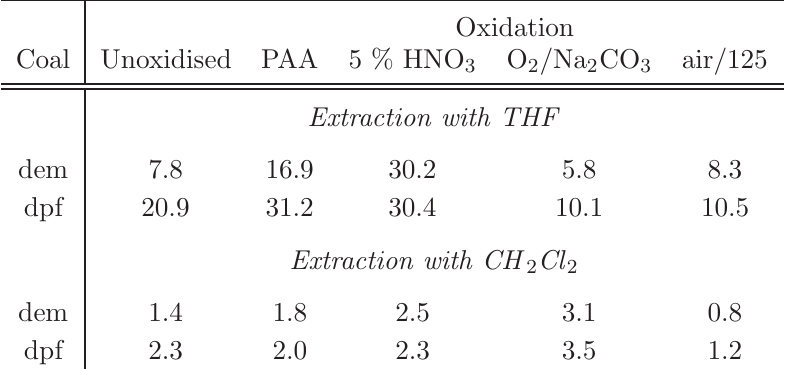
Table 2 The yields of extraction of the initial and oxidised coal samples with THF and CH 2 Cl 2